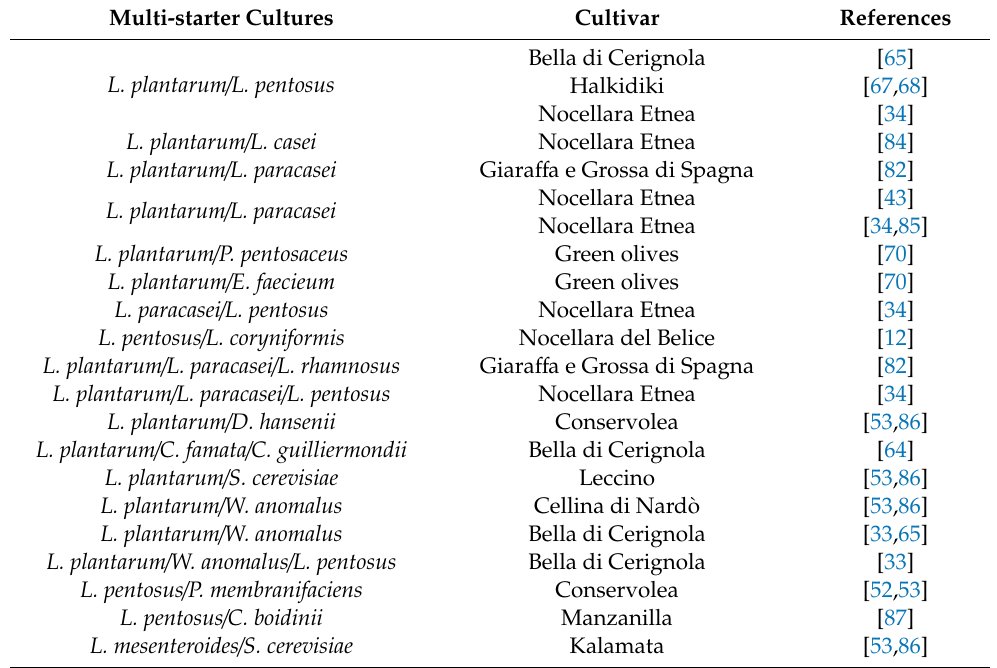
Table 4. Main multi-starter strains used for table olive